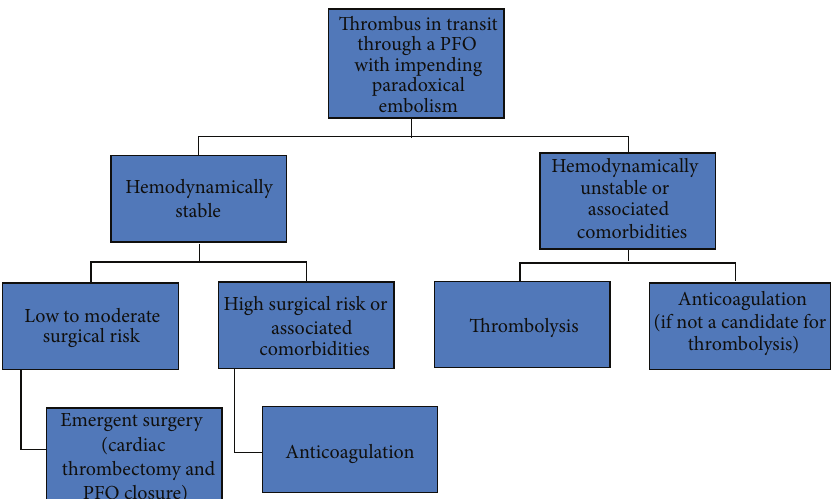
Figure 2: Diagram showing the different therapeutic options for a thrombus in transit through a PFO with impending paradoxical embolism.